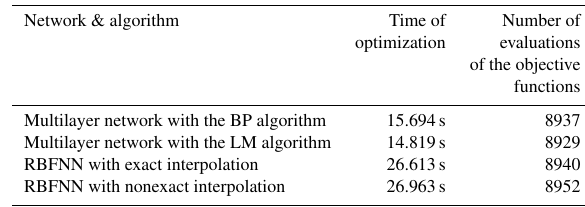
Table 1. Total time of optimization and number of evaluations of the objective functions.